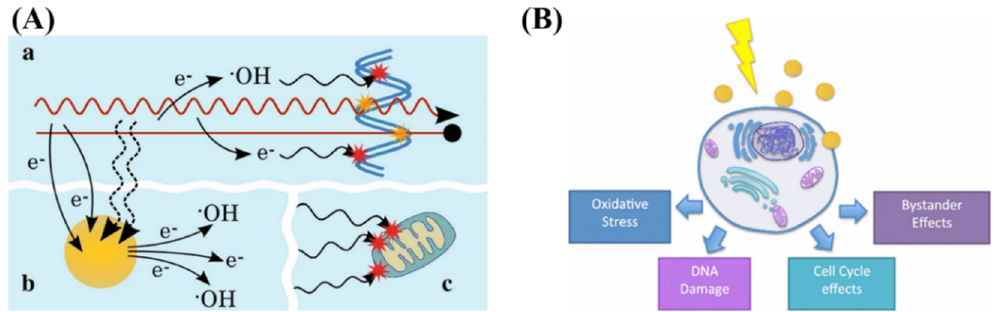
Figure 6. Radiosensitization and radiobiological effects. ( A ) Schematic showing chemical mechanism of GNP radiosensitization. While the radiation causes direct and indirect damage (yellow and red stars, respectively), there can be induction of secondary electrons and reactive oxygen species through gold nanoparticles. This can lead to damage to the DNA as well as secondary parts of the cell, such as the mitochondria. ( B ) GNPs can influence the cell through generation of reactive oxygen species, DNA damage, as well as cell cycle and bystander effects. Reprinted with permission from [110] and [118]. Copyright (2016, 2017) Springer Nature.